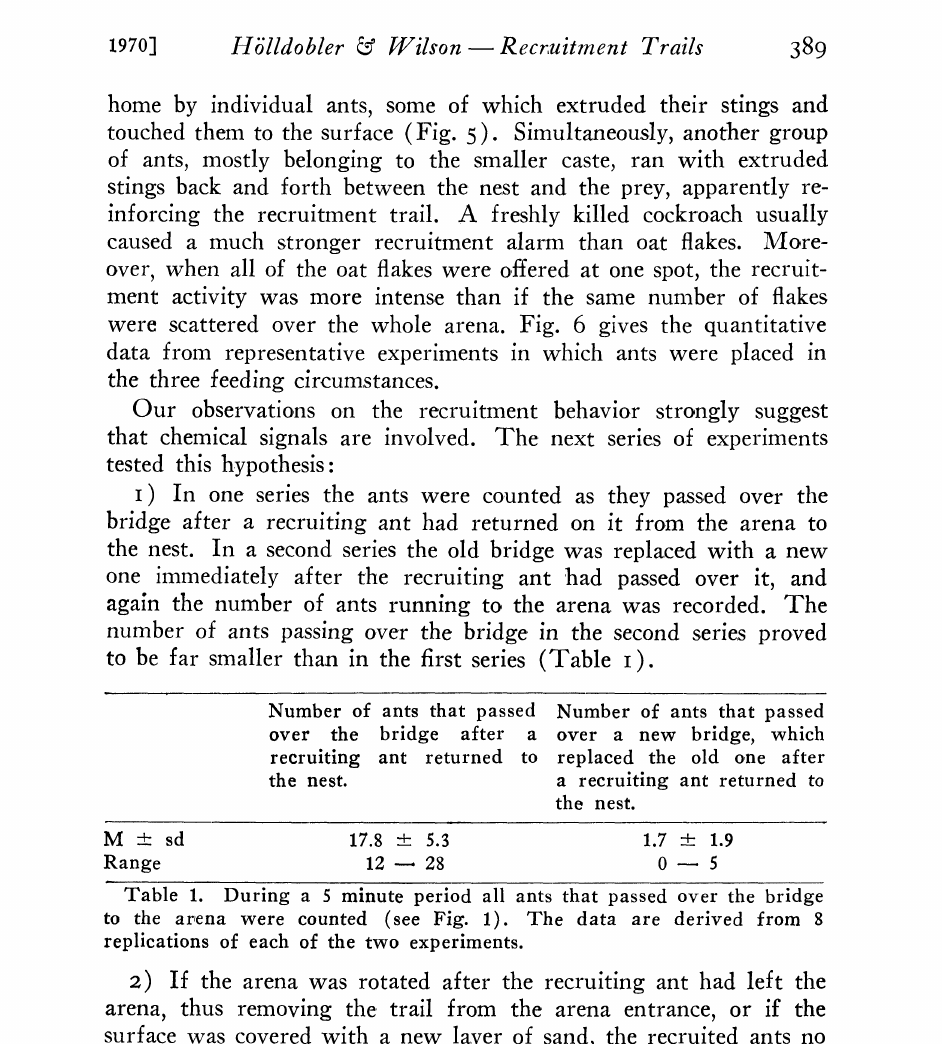
Table 1. During a minute period all ants that passed over the bridge to the athena were counted (see Fig. 1). The data are derived from 8 replications of each of the two